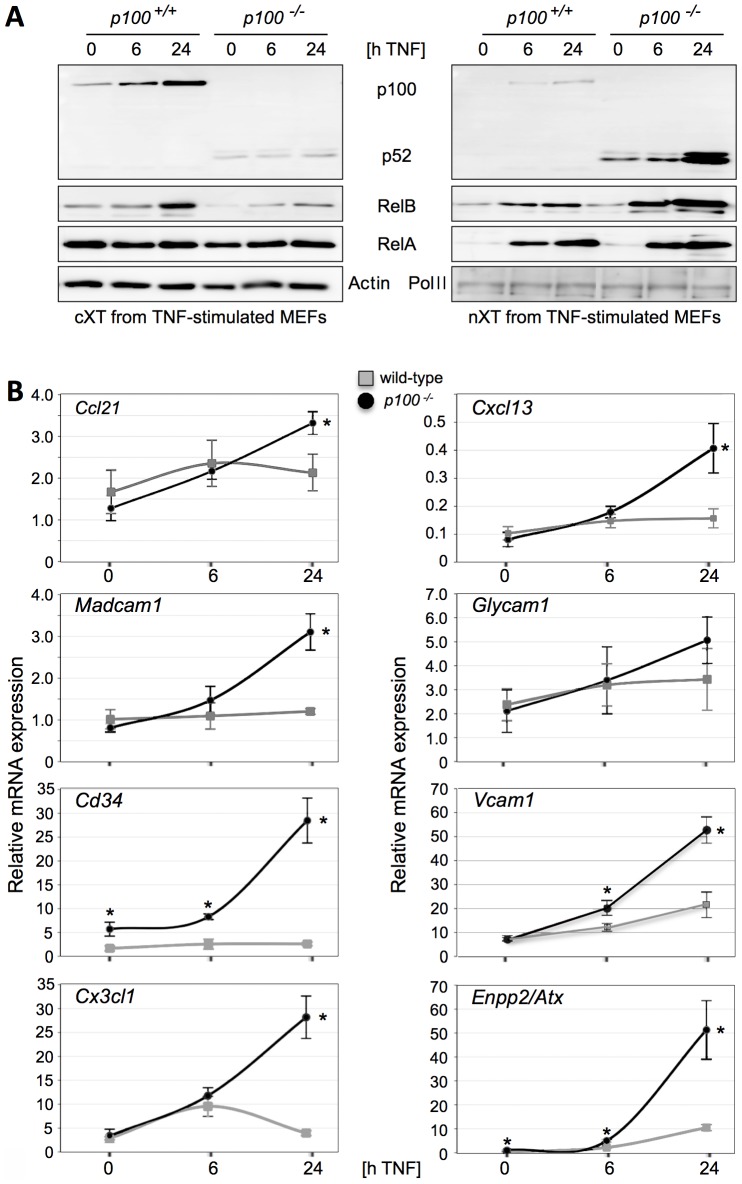
TNF synergizes with the lack of p100 in the induction of target gene expression.(A) Western blot of NF-κB family members in cytoplasmic and nuclear protein extracts (15 µg/sample) from unstimulated (0 h) and TNF-stimulated (6 and 24 h, 20 ng/ml recombinant murine TNF) wild-type and p100−/− MEFs. As cytoplasmic and nuclear loading controls β-actin and RNA Pol II were assayed, respectively. (B) Changes in mRNA levels of selected genes were analyzed by qRT-PCR. From 16 analyzed genes, 12 responded synergistically to TNF and the lack of p100 whereas only four genes responded similarly to TNF treatment of wild-type (grey squares) and p100−/− MEFs (black circles; see also Figure S4). qRT-PCR data represent n = 3 independent TNF stimulation experiments and are expressed as mean values ± SD. Differences between wild-type and p100−/− MEFs at each time-point were analyzed by Welch tests. P≤0.05 was considered significant (*).